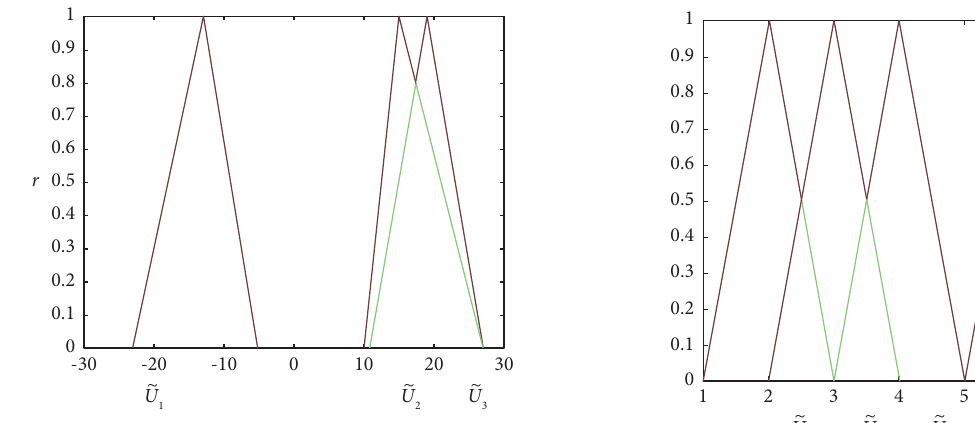
Figure 8: Chart of the restriction part of 􏽥 U